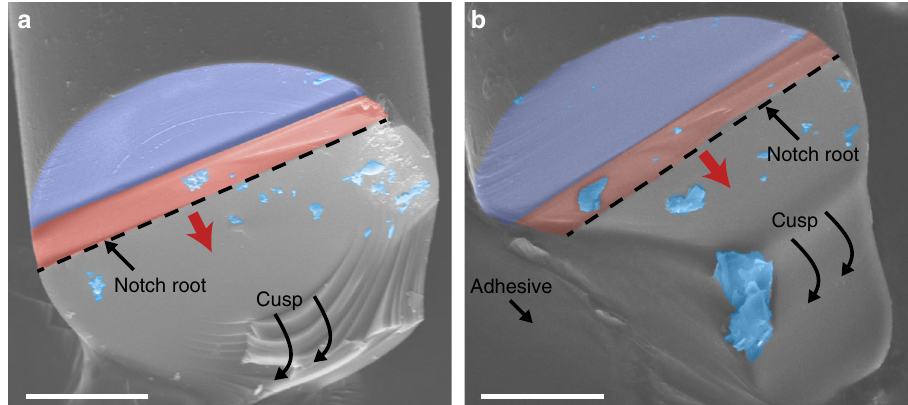
Fig. 6 Micrographs of fractured Ea . and Ta . spicules. Representative Ea . and Ta . spicules are shown in a and b , respectively. False color is used to mark important features. The purple region in both a and b corresponds to the coarse (higher current) FIB cut discussed in Section Spicule notching procedure. The red region in a and b corresponds to the fi ne (lower current) FIB cut. The blue regions correspond to debris that we assume collected on the fracture surfaces during specimen preparation. The red arrow denotes the direction of crack growth. The cusp feature in a and b is a feature of the three-point bending test con fi guration that appears for both the Ea . and Ta . spicules. In b , part of this feature is occluded by the adhesive used to mount the spicule to the aluminum stub. Scale bars are 10 μ m.